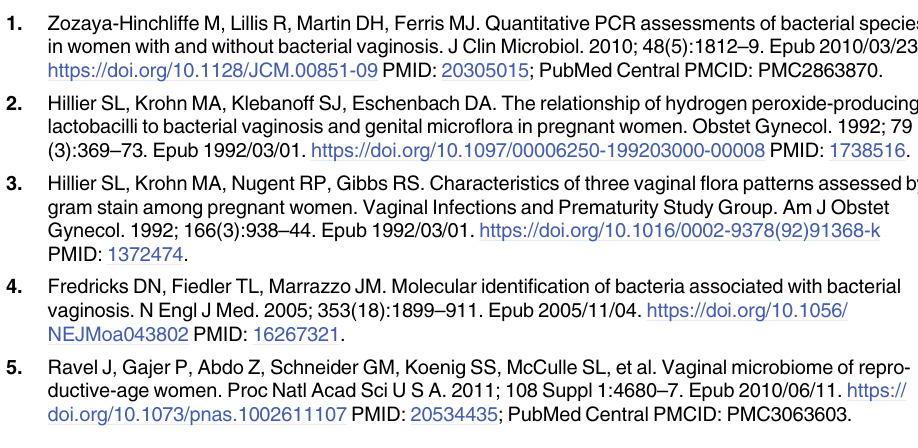
S3 Table. Reference and clinical isolates used to validate cpn60 primer specificity. HM numbers are references isolates obtained from BEI Resources. Clinical isolates were colony- purified from study samples and classified by sequencing their cpn60 amplicons. Gsp # [35]; GS # [28]. S1 File. Alignment of 101 Gardnerella cpn60 genes and primers. Open reading frames were extracted from the genome sequences in the NCBI database and aligned with ClustalW [69], and primers were positioned onto target aligned sequences, within Bioedit software [70]. Searches for complementary sequences to primers among non-target genes were negative. Sequences were categorized and labelled as in S1